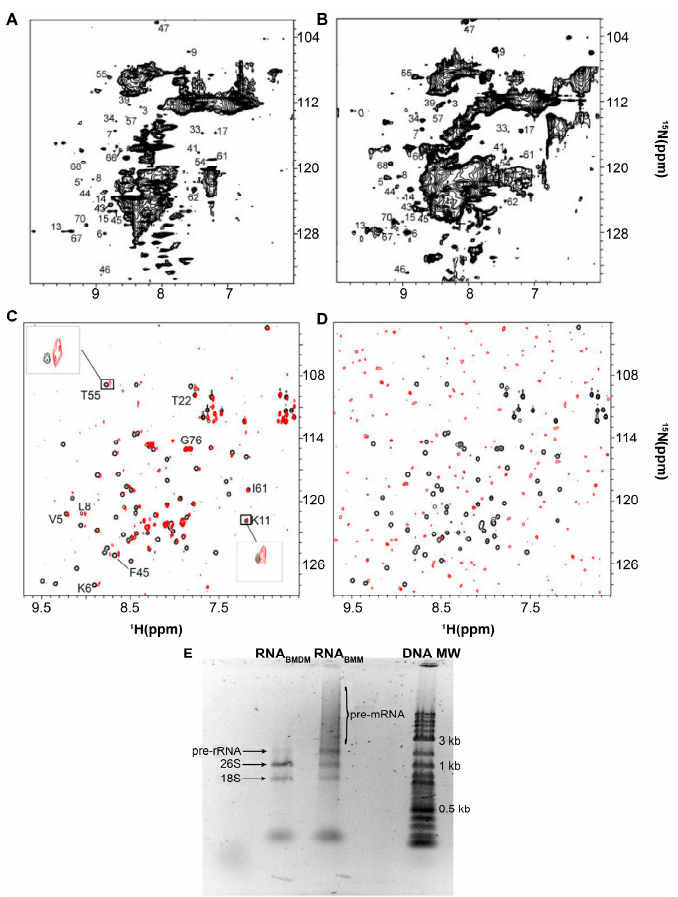
Figure 1. Total cellular RNA alters in vitro spectra of Ubiquitin, Ubq. ( A ) In-cell 1 H- 15 N heteronuclear single quantum coherence, HSQC, NMR spectra of [ U - 15 N] Ubq in P. pastoris after 24 h of methanol induction and ( B ) 48 h of methanol induction. ( C ) Overlay of the in vitro 1 H- 15 N HSQC spectra of 10 µM [ U - 15 N] Ubq in the absence (black) and presence (red) of 30 mg/mL of RNA BMM and ( D ) 30 mg/mL of RNA BMDM . Insets in panel C show a broadening of selected residues of free Ubq (black) due to the interaction with RNA BMM (red). ( E ) RNA from yeast cells grown with methanol, RNA BMM , contains an amount of pre-mRNA and pre-rRNA larger than that of RNA from cells grown with a methanol/dextrose carbon source, RNA BMDM . DNA MW indicates molecular weight markers. The numbers in panels A, B and C indicate some of the peak assignments. Panels A and B are adapted from Bertrand et al. (2012) [40]. Panels C , D and E are adapted from Majumder et al. (2016)